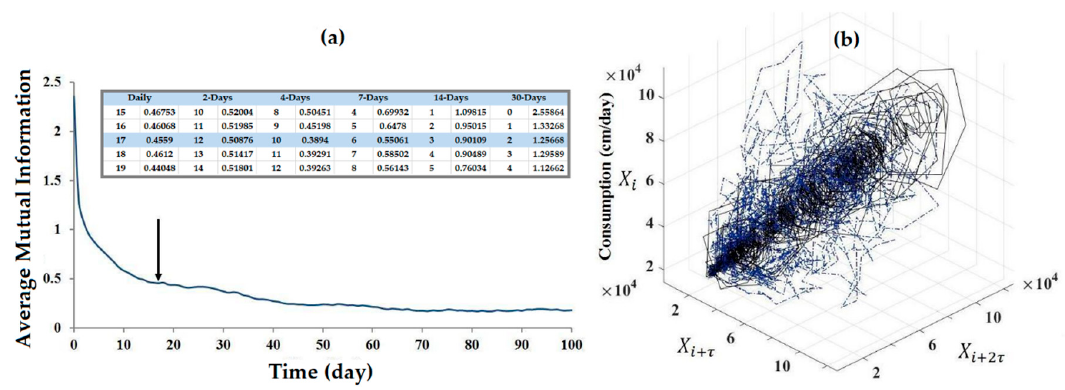
Figure 4. ( a ) Average mutual information for the daily value ( τ = 17); ( b ) reconstructed phase space by ( τ and 2 τ -day lag time). Table 2. Average mutual information and correlation exponent values in di ff erent temporal resolutions.